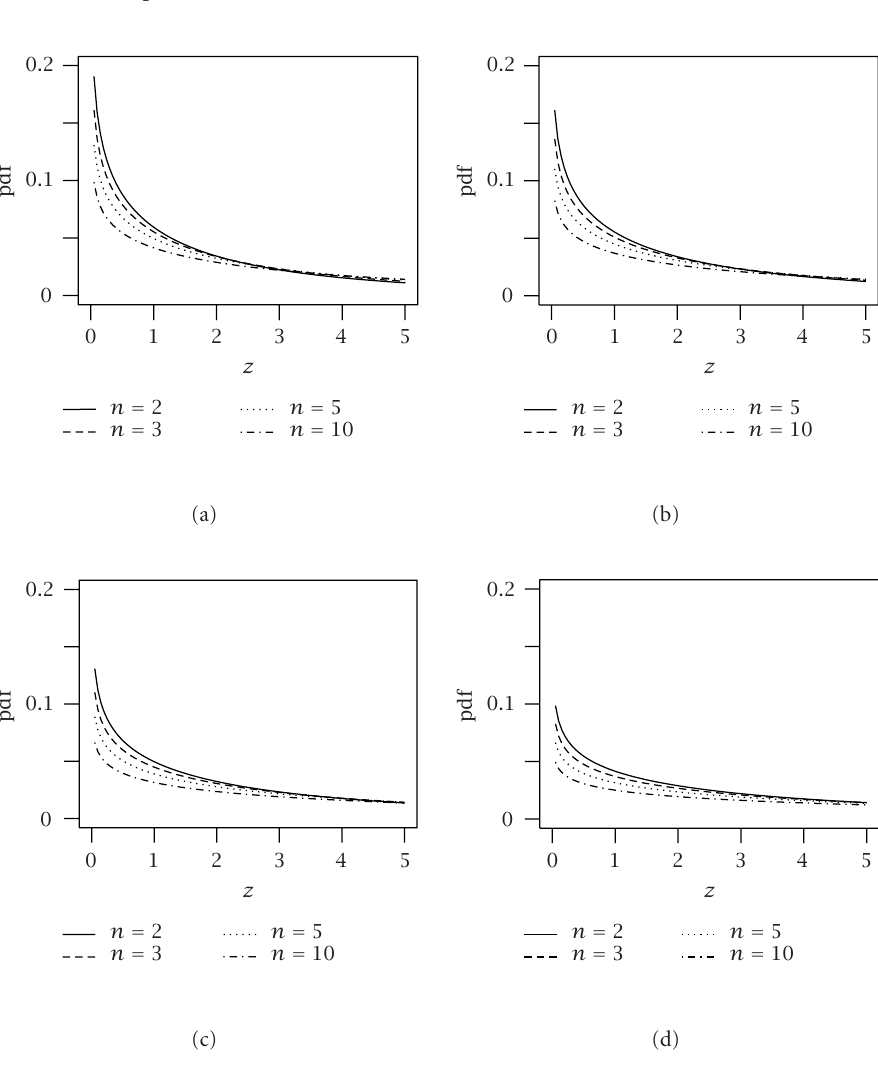
Figure 2.1 illustrates possible shapes of the pdf (2.1) for selected values of m and n . The four curves in each plot correspond to selected values of n . The e ff ect of the parameters is